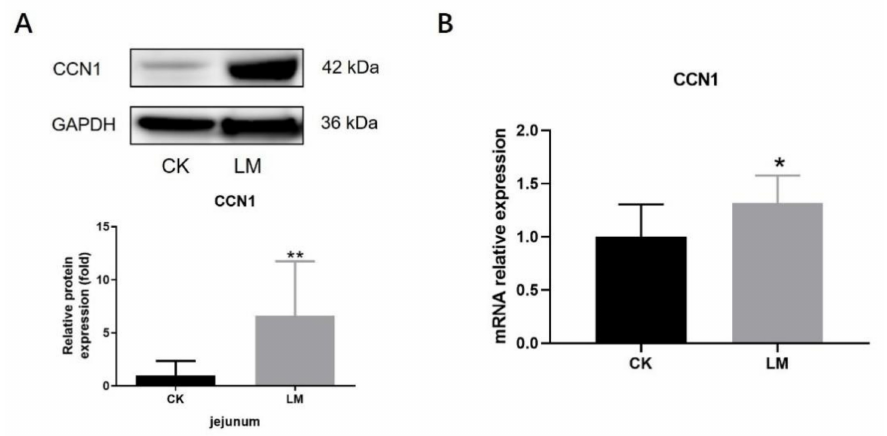
Figure 2. The changes in CCN1 response to L. monocytogenes infection in mice. ( A ) Western blot of CCN1 in the jejunum. ( B ) mRNA levels of CCN1 in the jejunum. * p < 0.05, ** p < 0.01.